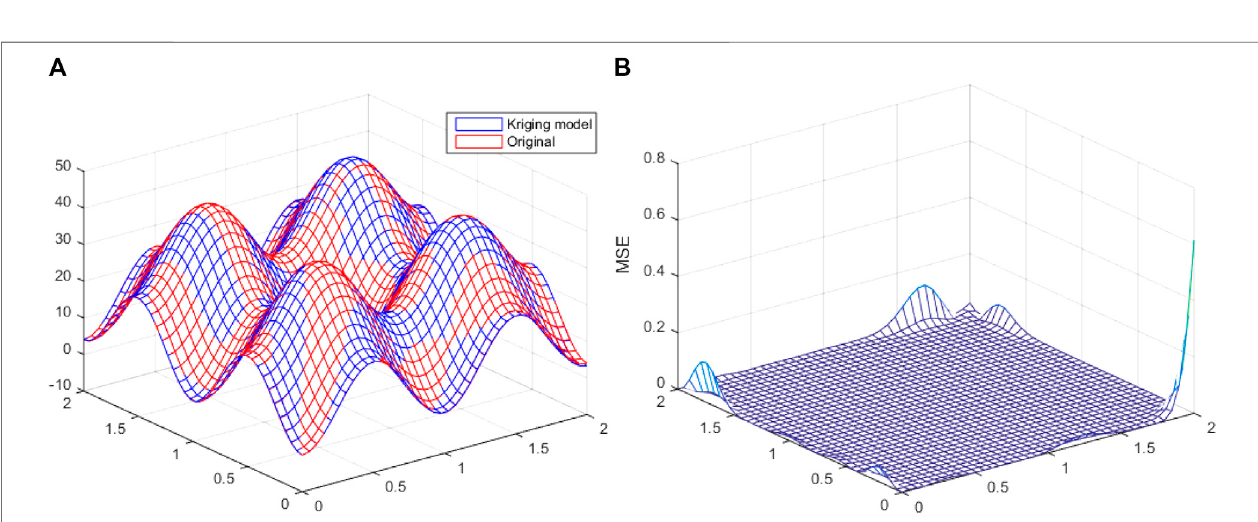
Frontiers in Energy Research |